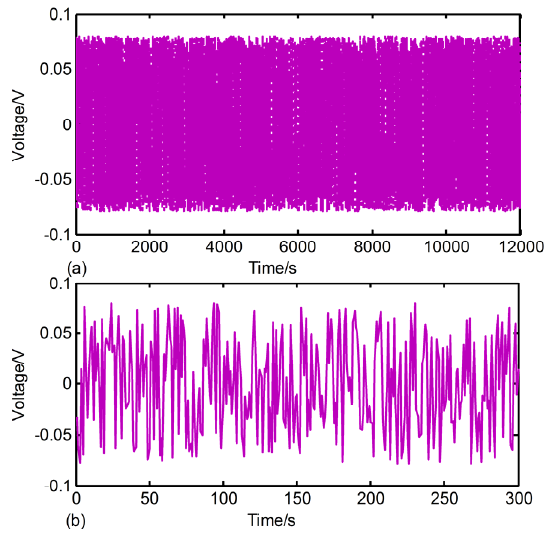
Figure 8. Random voltage noise: ( a ) Random noise profile; ( b ) Zoom plot of random noise profile.